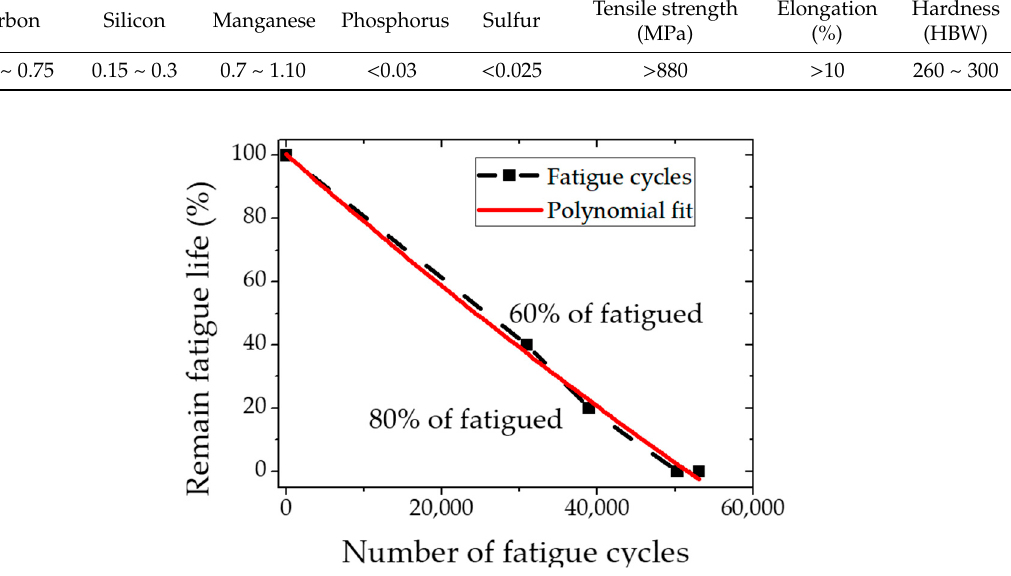
Figure 4. Fatigue life of KR 60 rail specimens.